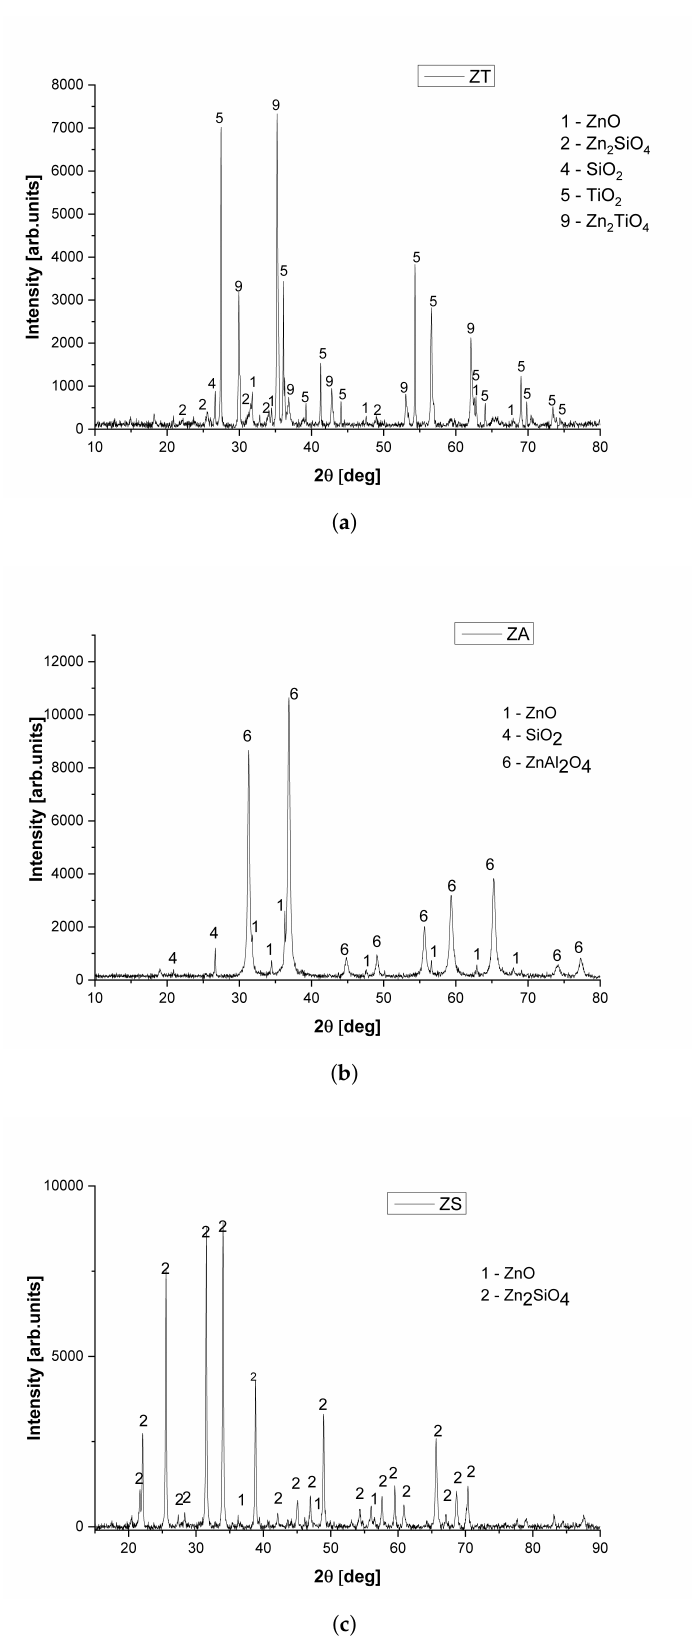
Figure 2. XRD pattern of fresh ZT sorbent ( a ), ZA sorbent ( b ) and ZS sorbent ( c